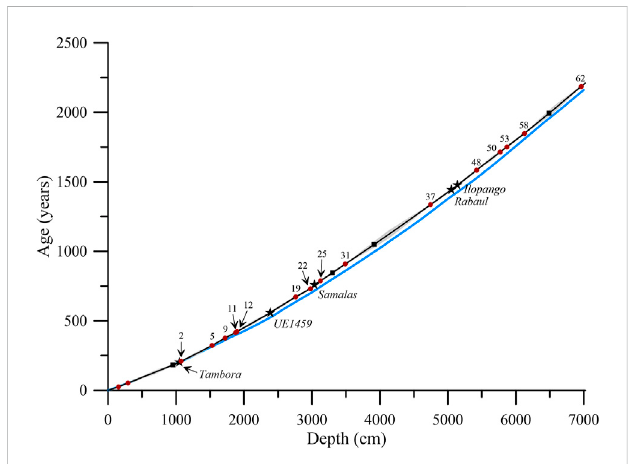
FIGURE 5 The depth-age function for the 0 – 70 m interval of the Vostok snow- fi rn thickness. The different symbols show the absolute age markers, as well as the tie-points used for the cross-dating of the three cores (VK16, VK18, and VK19) – the same as in Figure 3. By the blue line the depth-age scale AICC 2012 (Veres et al., 2013) is